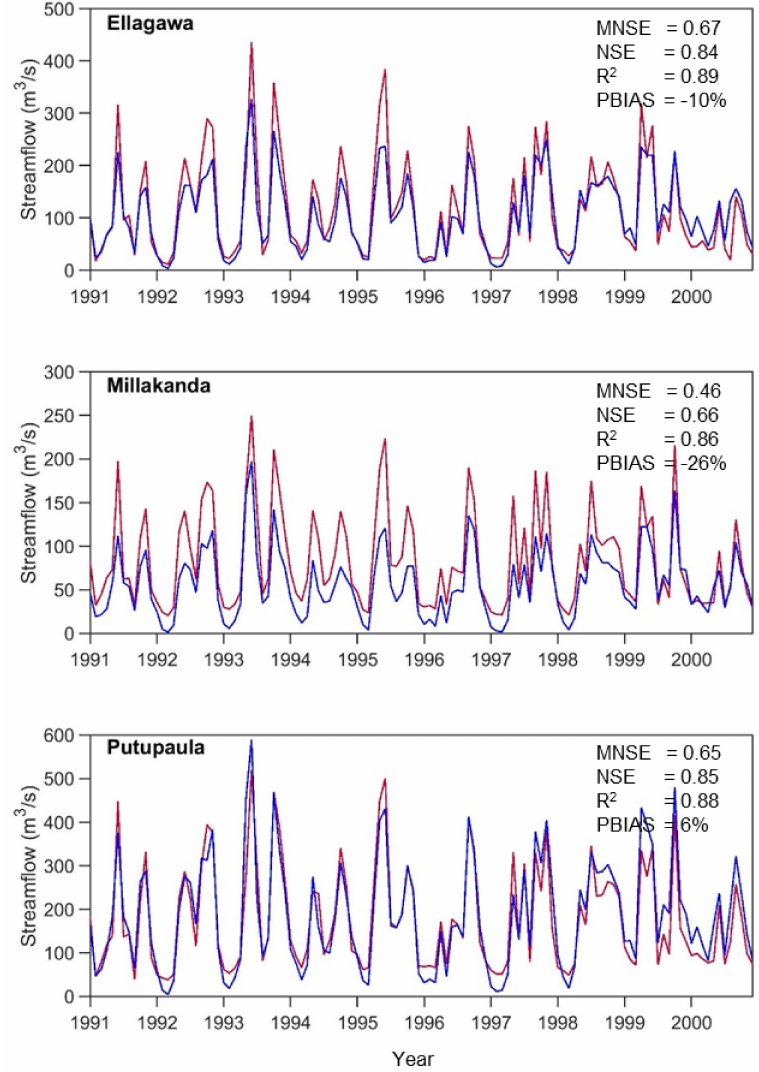
Figure 2. Comparison of simulated and observed monthly streamflow of the best simulations at three stations during the calibration period (1991–2000). Red and blue lines indicate the observed and simulated data,